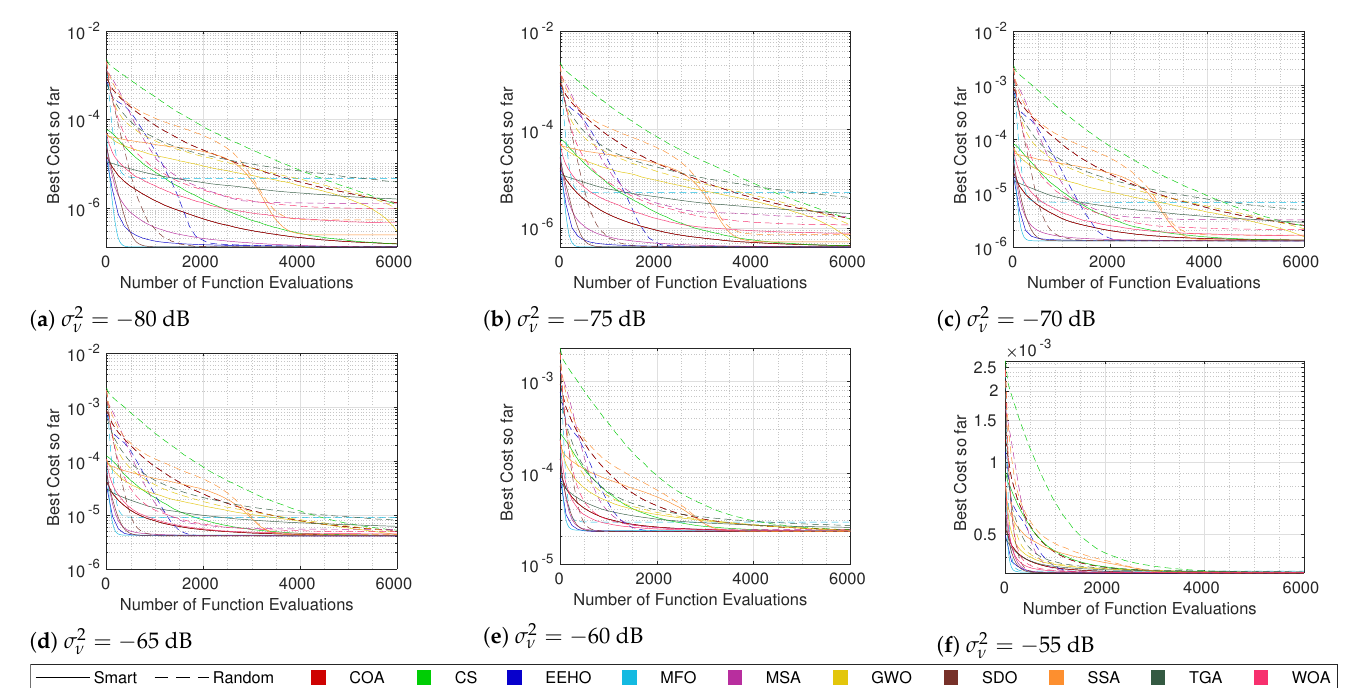
Figure 9. Cost convergence when using smart and random initialization for each algorithm when N = 12.